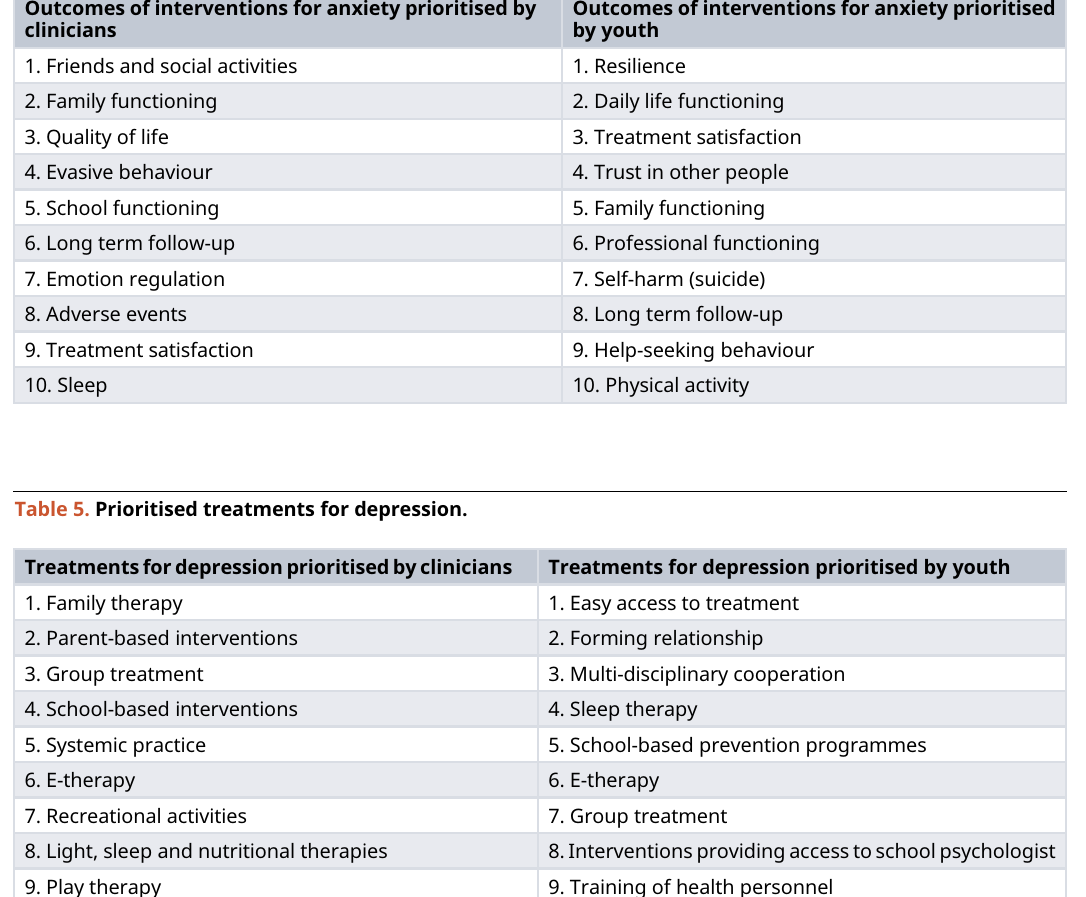
Table 4. Prioritised outcomes of interventions for anxiety. Outcomes of interventions for anxiety prioritised by clinicians